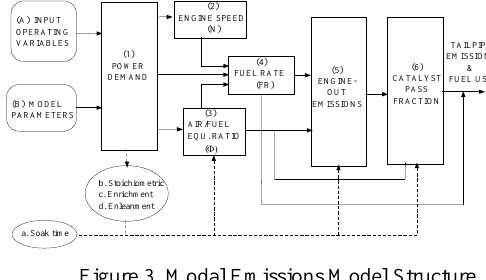
Figure 3. Modal Emissions Model